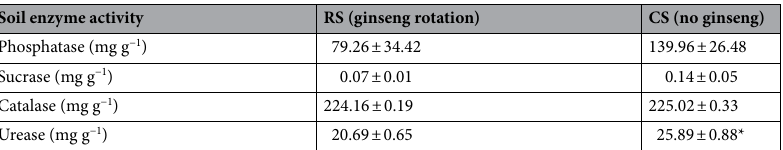
Table 2. Comparison of enzyme activities between 10-year post-ginseng rotation soil (RS) and soil in which no ginseng was grown (CS) before ginseng planting. *Statistically significant difference at P < 0.05 (T test). Mean ± SE (n = 4) data shown.